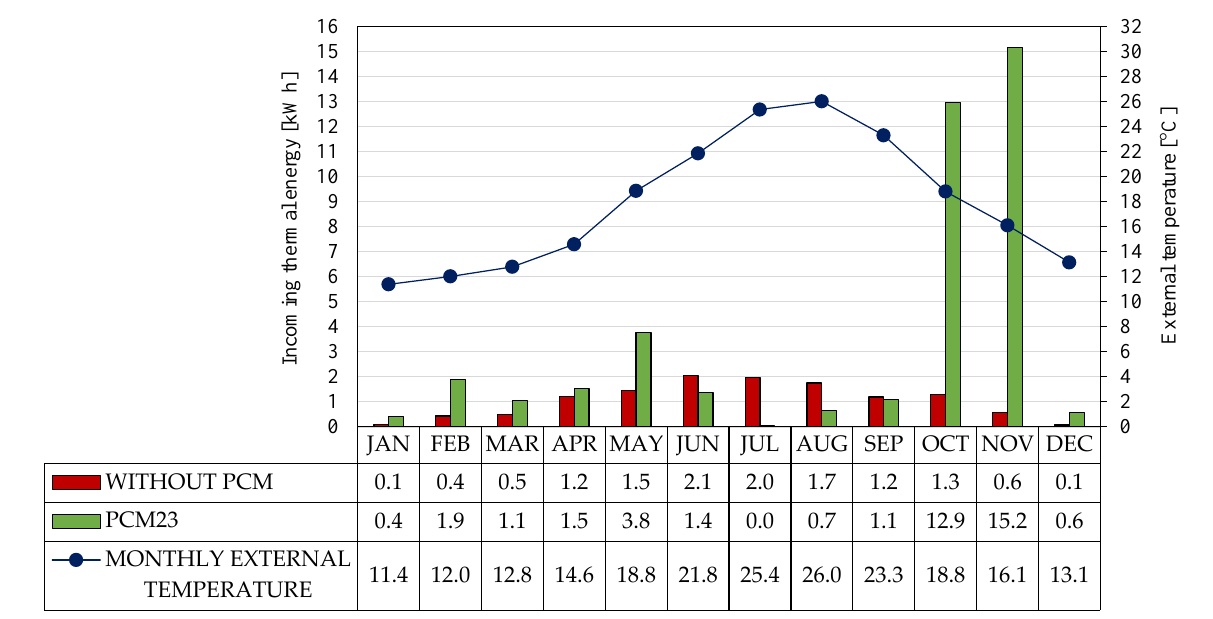
Figure 10. Comparison of the incoming thermal energy through the SuberWall panel between CASE 1 and CASE 2 with PCM23.